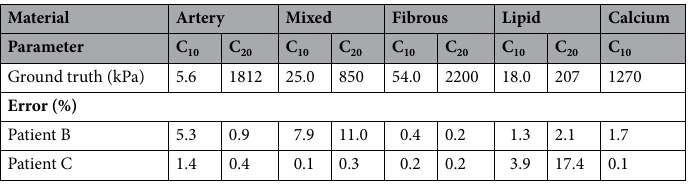
Table 2. Final errors in Yeoh material parameter recovery during a single run for Patients B and